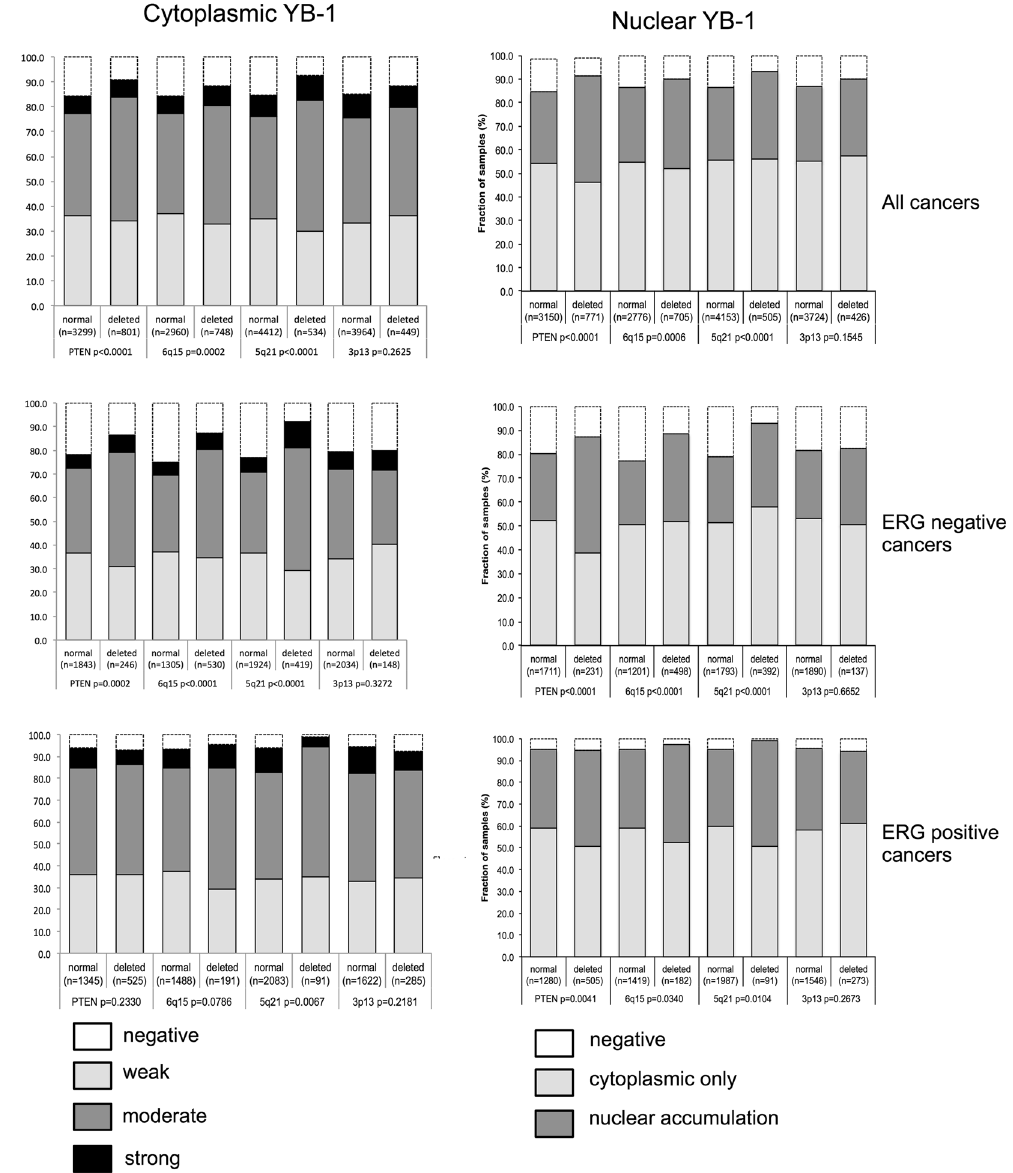
Figure 3. Association between YB-1 staining and deletion of 10q23 (PTEN), 5q21 (CHD1), 6q15 (MAP3K 7 ), 3p13 (FOXP1) in all cancers, the ERG-negative and ERG-positive